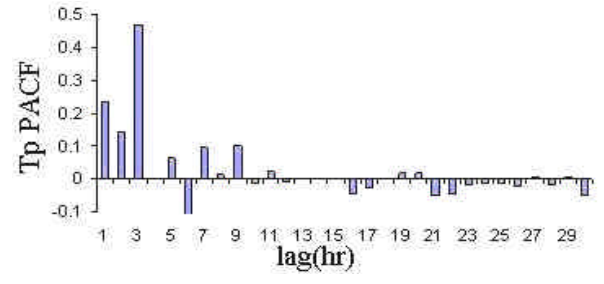
time lag. Figure13. Significant wave height partial auto correlation with 1hr time lag